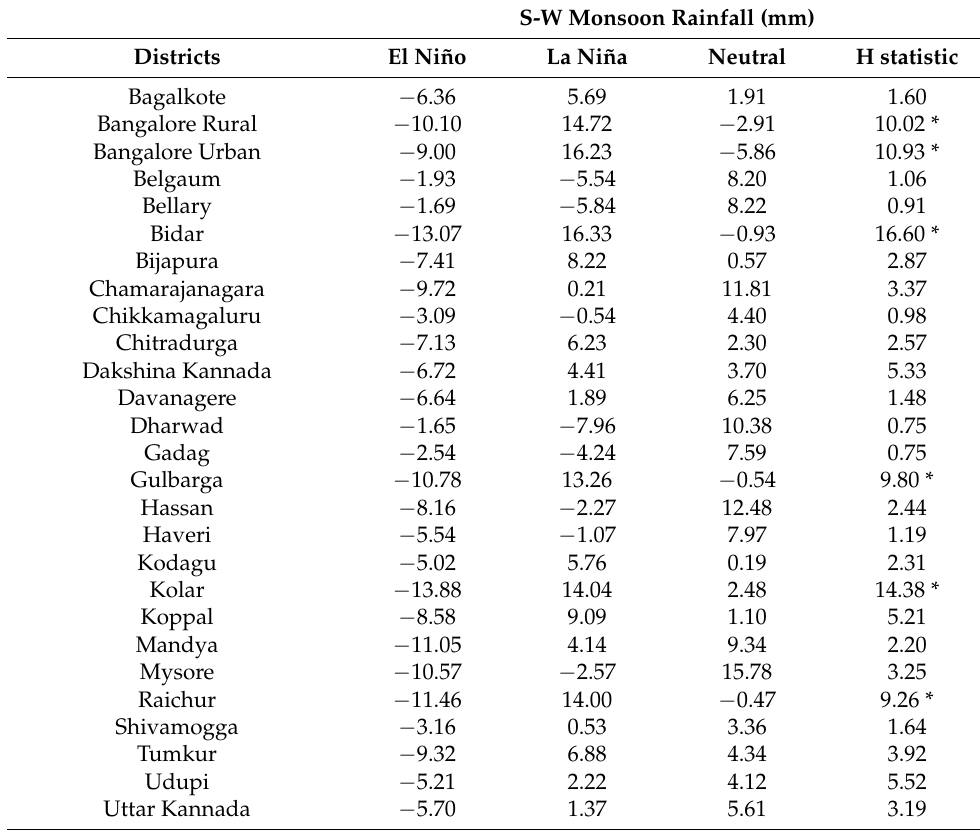
Table 6. Mean percentage deviation of S-W monsoon rainfall from normal under El Niño, La Niña, and neutral ENSO phases (1950–2018) n = 69